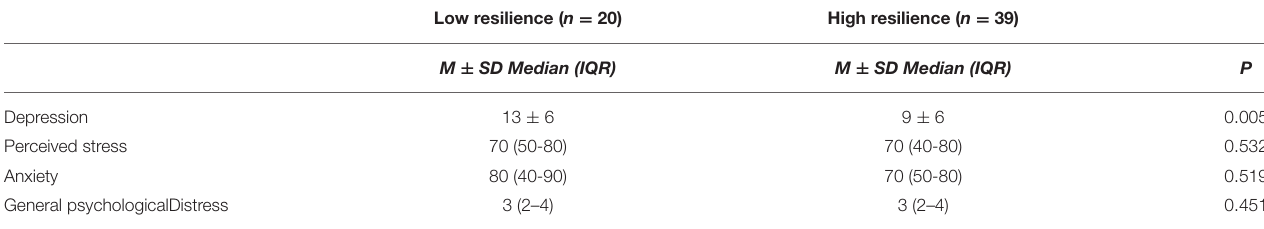
TABLE 2 | Differences in the EPDS, perceived stress, anxiety, and general psychological distress by level of